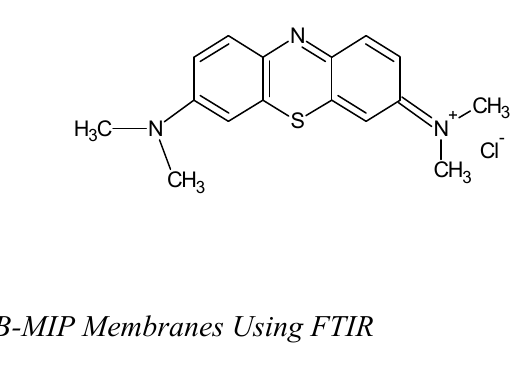
Figure 1. Chemical structure of